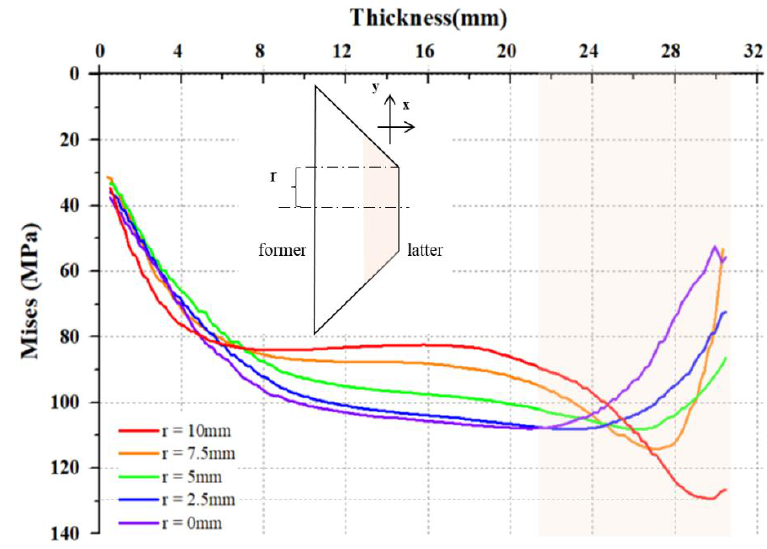
Figure 12. The stress along x -axis of sample as different distances to the central line.